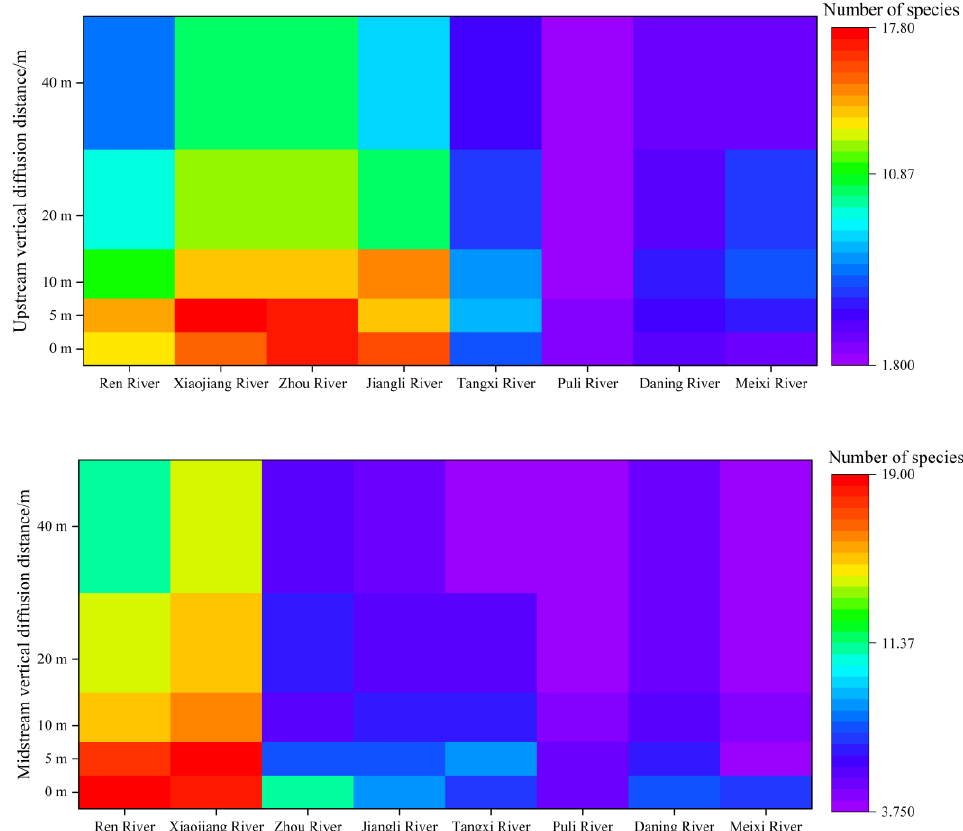
Figure 6. Heatmap of IAS close to and far from riverbanks.